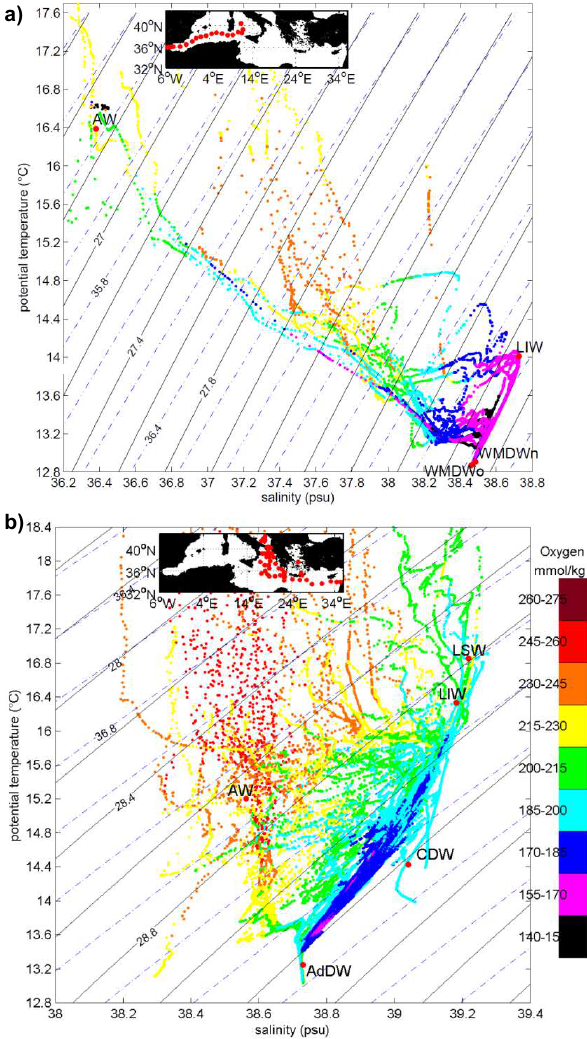
Figure 2a. T – S diagrams of the western (a) and eastern (b) Mediterranean Sea. Colours represent the concentration of oxygen in µmolkg − 1 . All depth levels from 0m to bottom are taken into ac- count. The locations of water mass sources are indicated by red dots (AW=Modified Atlantic Water, LSW=Levantine Surface Water, LIW=Levantine Intermediate Water, WMDW=Western Mediter- ranean Deep Water, AdDW=Adriatic Deep Water, ADW=Cretan Deep Water). The inset panels show the location of considered sta- tions. Note that the scales of T and S of the two panels are not identical. Data are from cruise M84-3 and P414 in spring 2011.